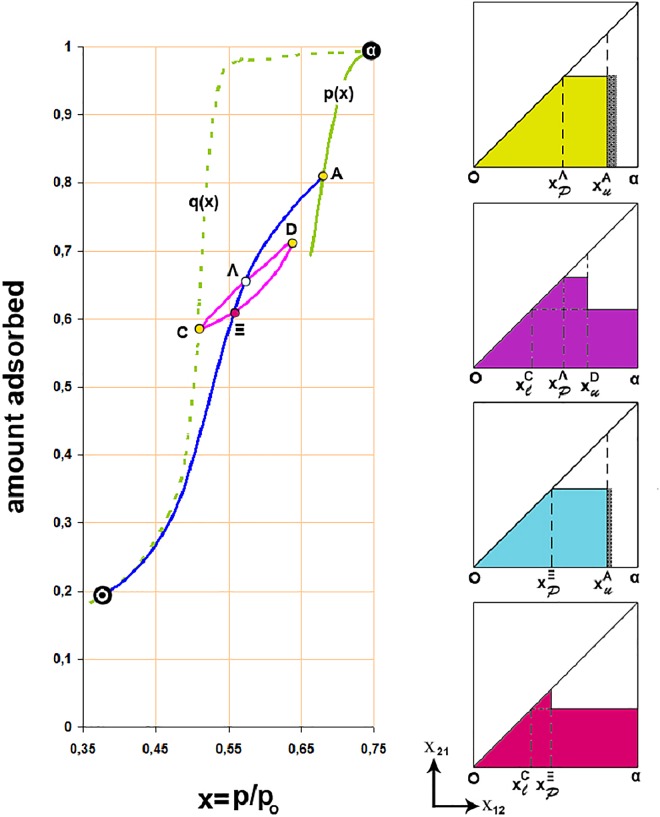
Effect of the adsorbed film on scanning the hysteresis loop of CH2Br2/Vycor adsorption isotherm according to theorem-6 of the domain theory.Points Λ and Ξ are approached from different routes; ΑΛΞΟ is a primary descending curve originated from the ascending boundary p(x) and CΞDΛC is a loop originated from the descending boundary q(x), α and O are respectively the upper and lower closure points of the adsorption isotherm. The complexion diagrams for common points are shown too; hatched areas indicate the correction needed to be taken into account for the adsorbed film in order theorem-6 to be valid. Note that the thickness of the film increases with pressure.